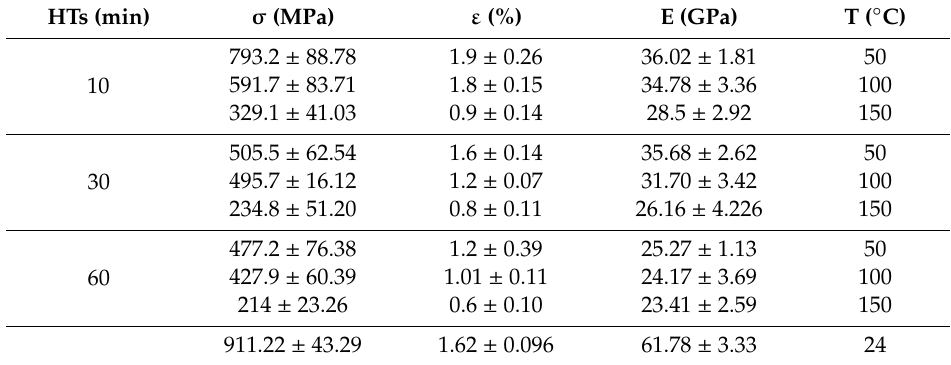
Table 2. Variation of mechanical properties as a function of temperature and temperature ‘hold time